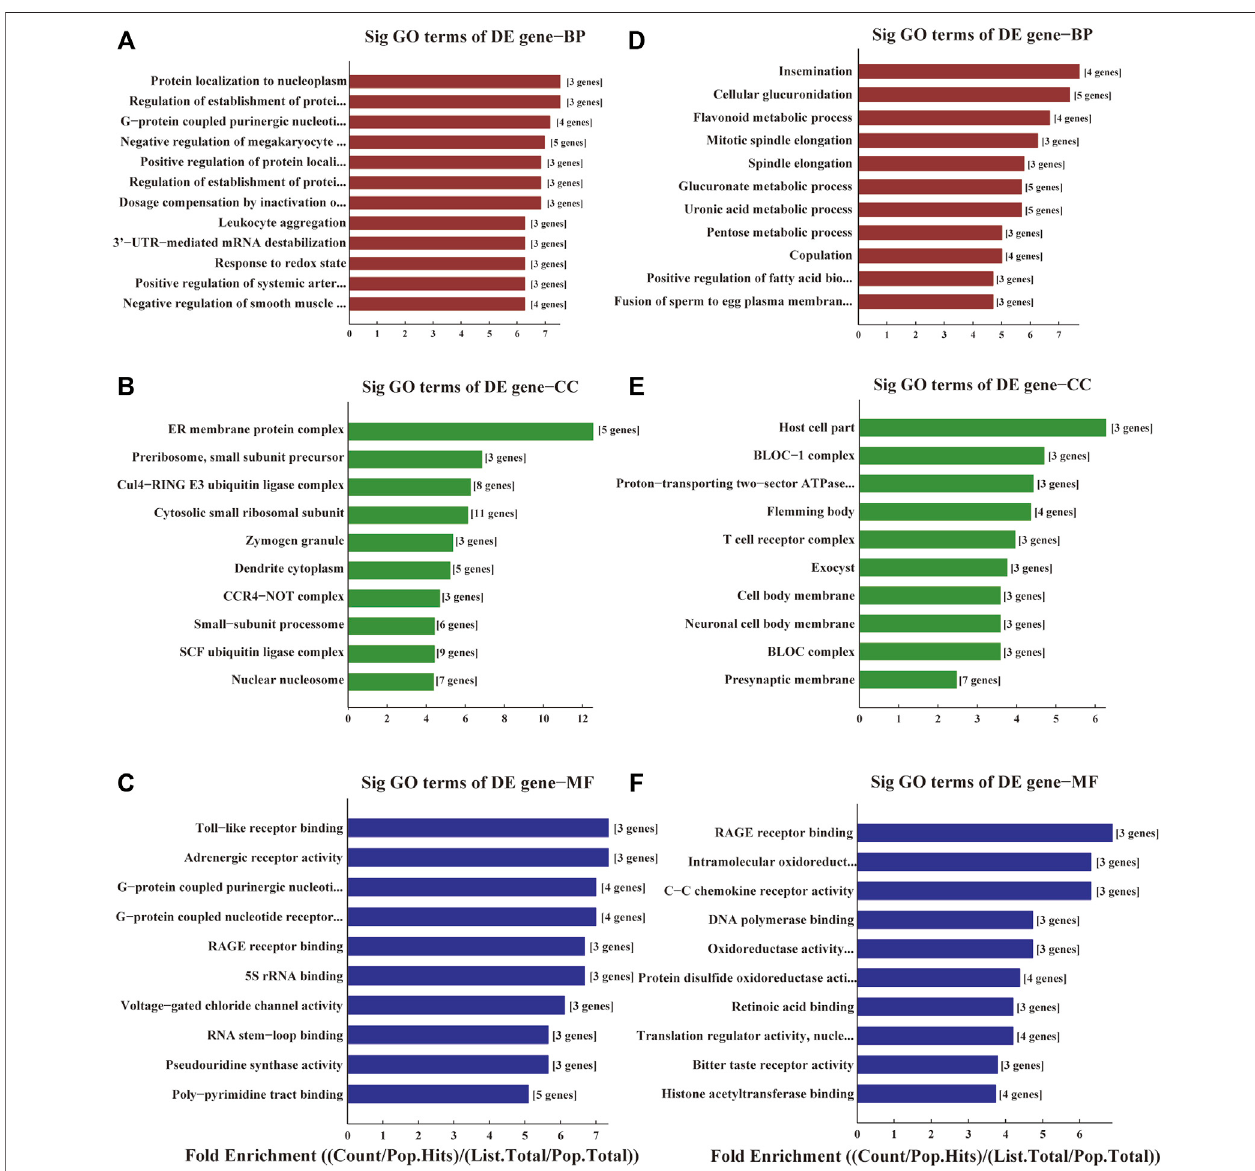
FIGURE 2 | GO analyses of the DE genes among ischemic stroke patients versus non-stroke controls. GO terms of Biological Process (BP), Cellular Component (CC) and Molecular Function (MF) for the DE upregulated (A – C) and downregulated genes (D – F).